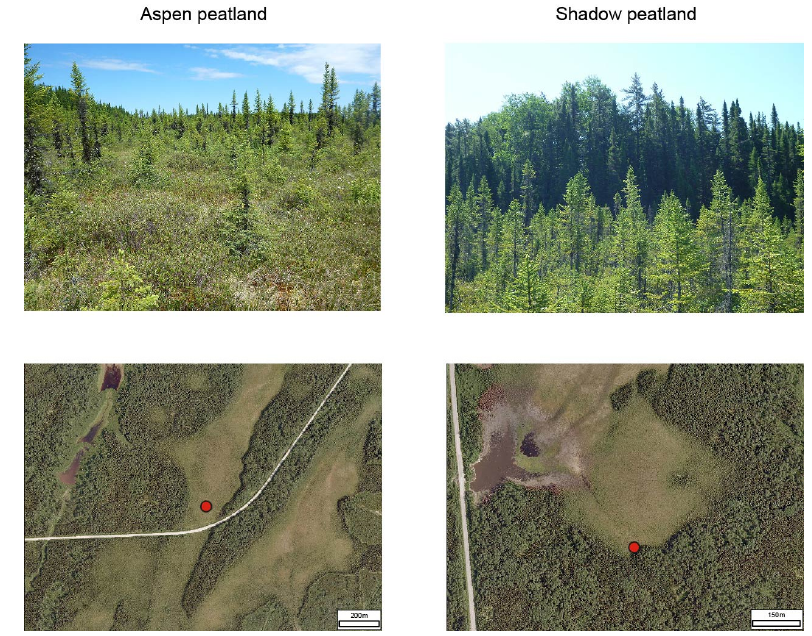
Figure 2. Study sites (Aspen and Shadow peatlands) where paleoecological reconstructions were conducted. Upper portion: overview of the peatlands and their forest environment. Lower portion: aerial photographs and location of sedimentary cores ( red dots).